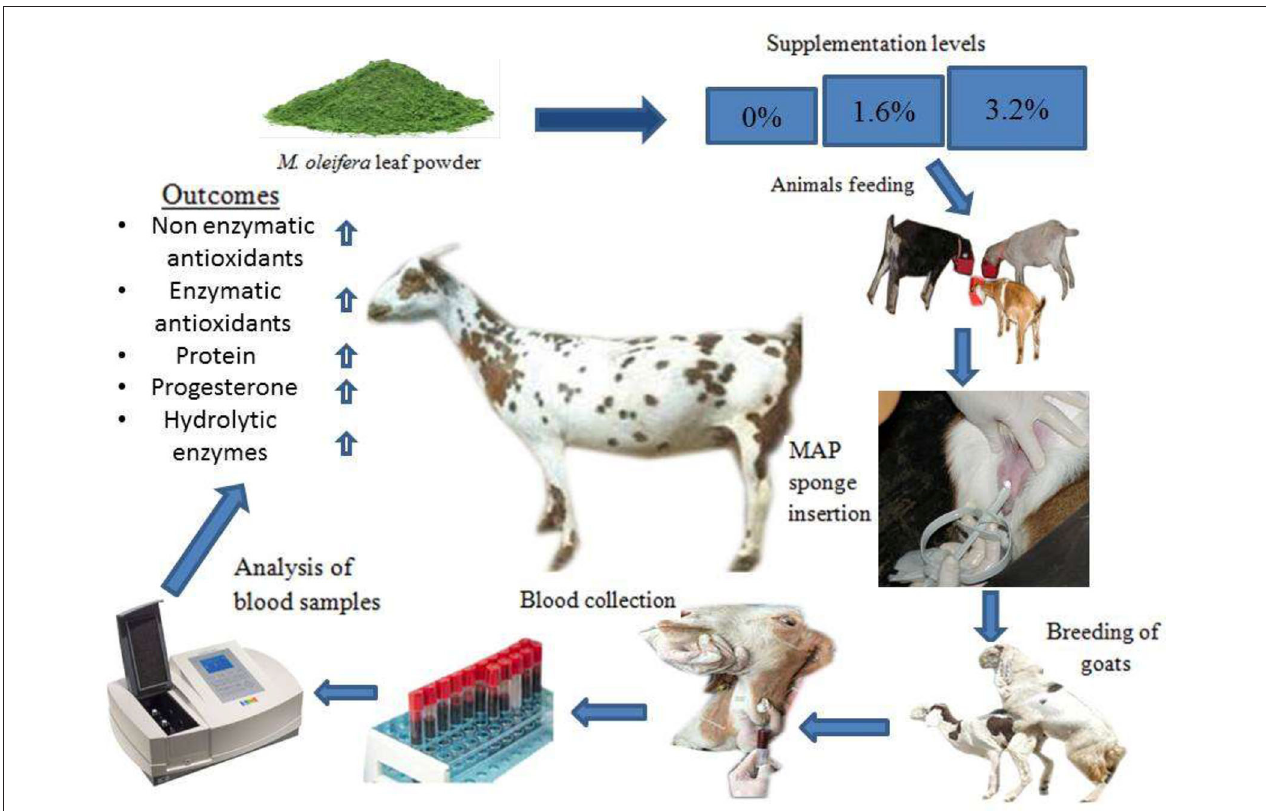
FIGURE 1 | Graphical abstract.